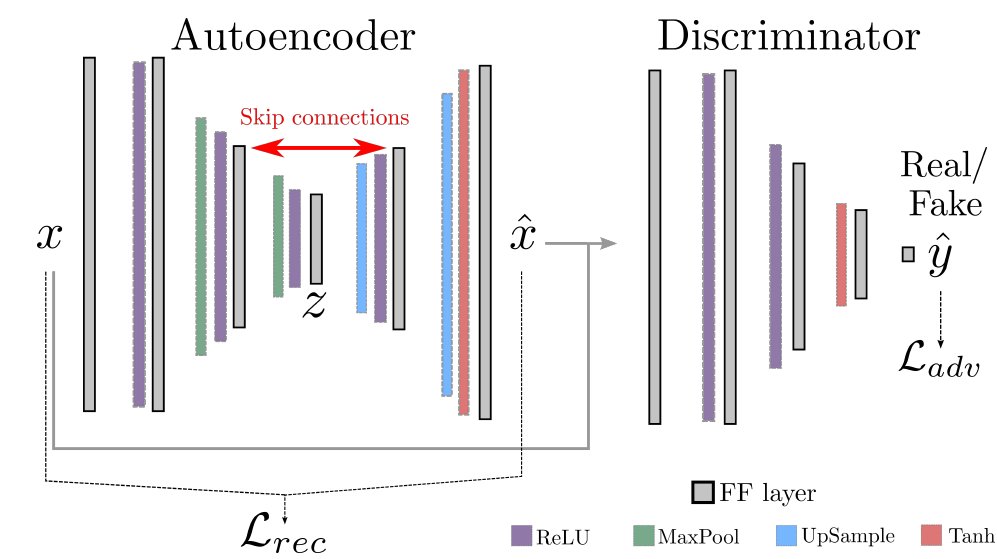
Figure 1: Sketch of the GAN architecture we used for the phase transition detection. The AE takes in input a vector with the eigenvalues of the ES ( x ) and operates an encoding and a decoding to its reconstructed version ˆ x . The discriminator takes in input x or ˆ x and gives a real number ˆ y